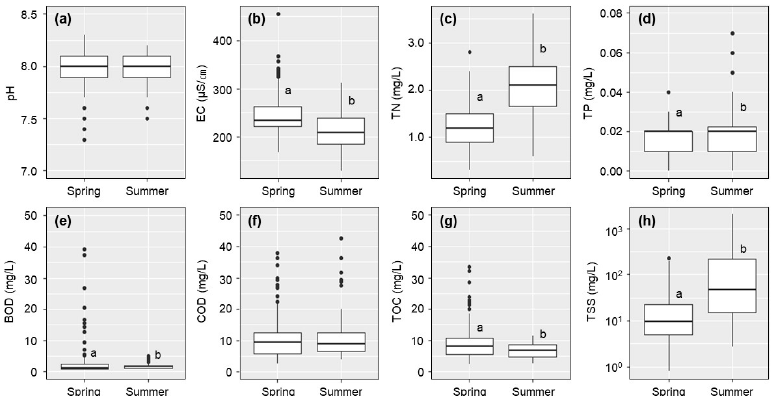
Figure 5. Comparison of observed water quality parameters (i.e., ( a ) pH, (b) EC, ( c ) TN, (d) TP, ( e ) BOD, ( f ) COD, ( g ) TOC, and ( h ) TSS) between spring (E1 − E6) and summer (E7 − E10) in the